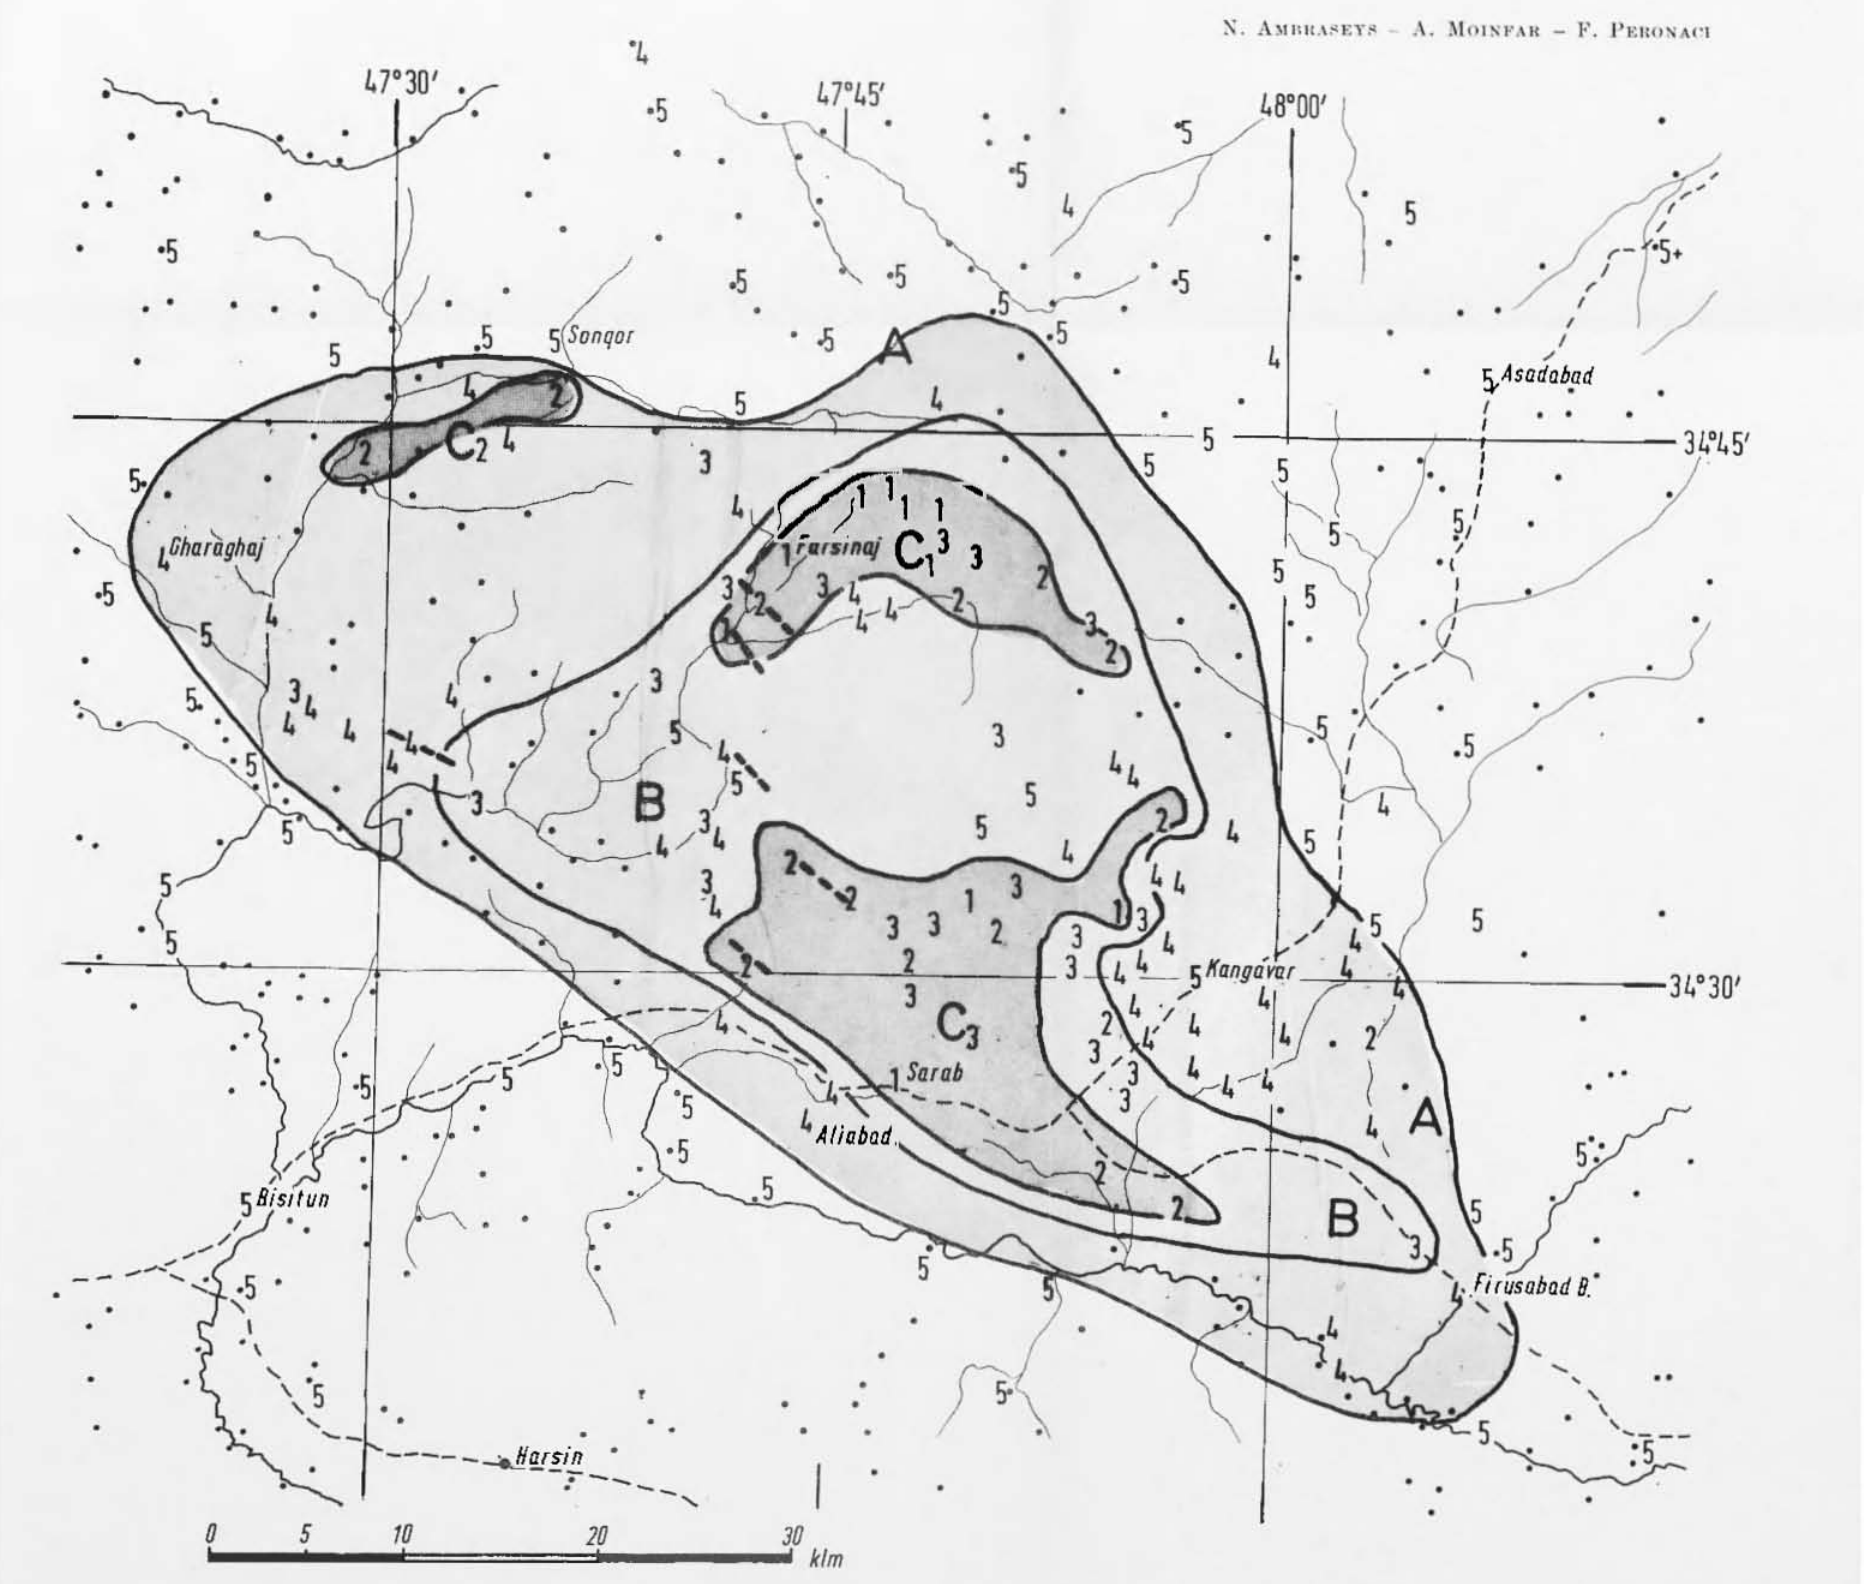
Fig. -1. - Daml1-gc mal'. )fumerals show 10l'alioll or lli!cckd villagcll I1.nd dC,!l,'r(',c of